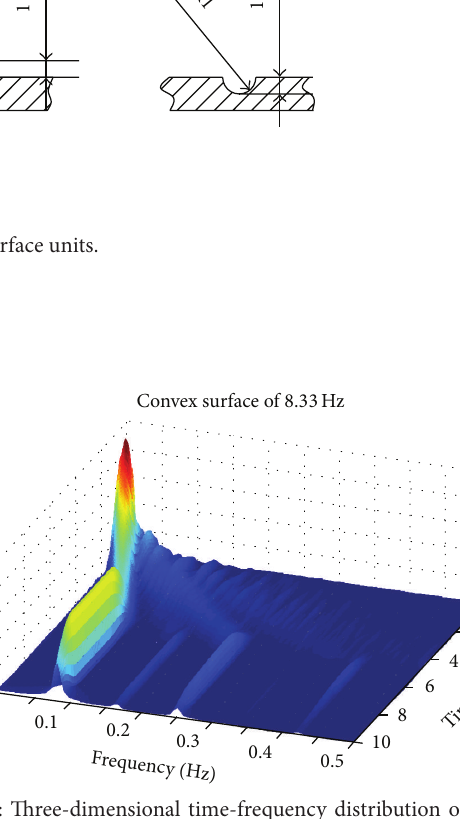
Figure 9: Three-dimensional time-frequency distribution of fric- tion force between convex surface and rape specimen when recip- rocating frequency is 8.33